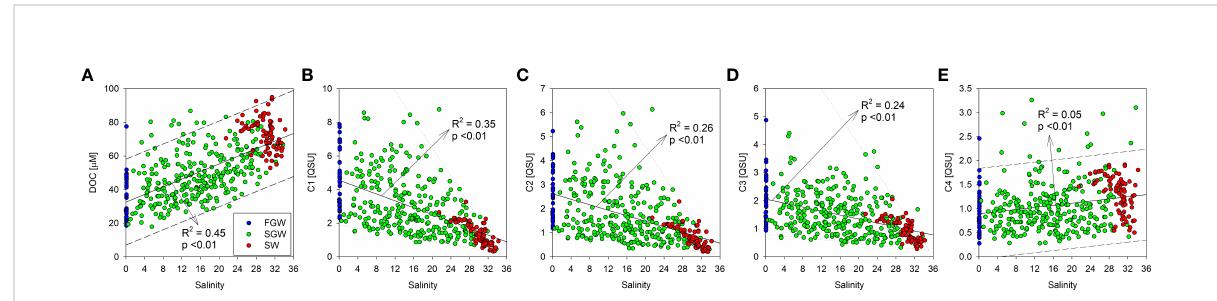
FIGURE 4 Scatterplots of the DOC and the FDOM components (C1 – C4) against salinity in the FGW, SGW, and SW. The solid lines (A – E) and the dashed lines (A, E) indicate the regression lines and the prediction intervals of the scatterplots, respectively. The dotted lines indicate the upper and lower limit of the relationship between FDOM H and salinity (B – D) .